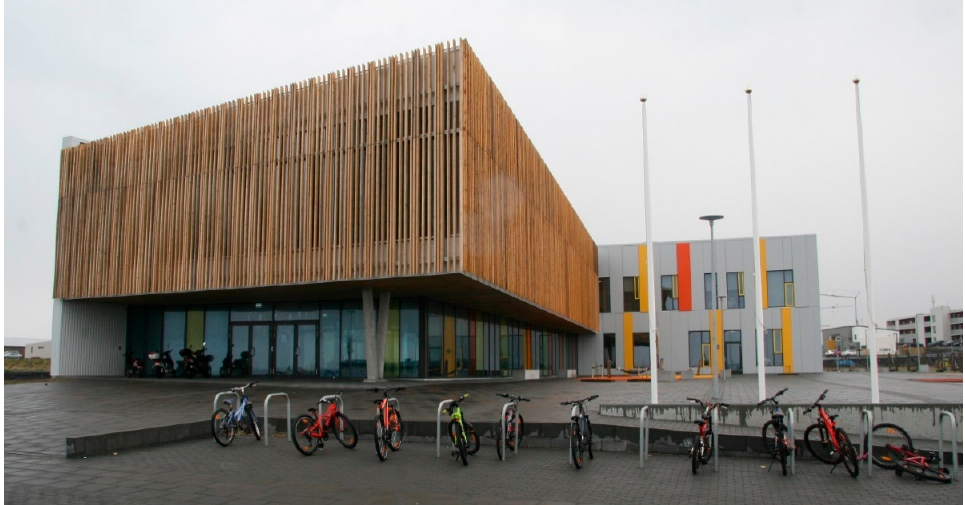
Figure 1. Stapaskoli, compulsory school in Reykjanesbaer. The main entrance and entrance hall are underneath a grand library on the upper floor. The administrative section can be seen to the right, protruding southwards, on top of a classroom unit for grades 5 and 6.